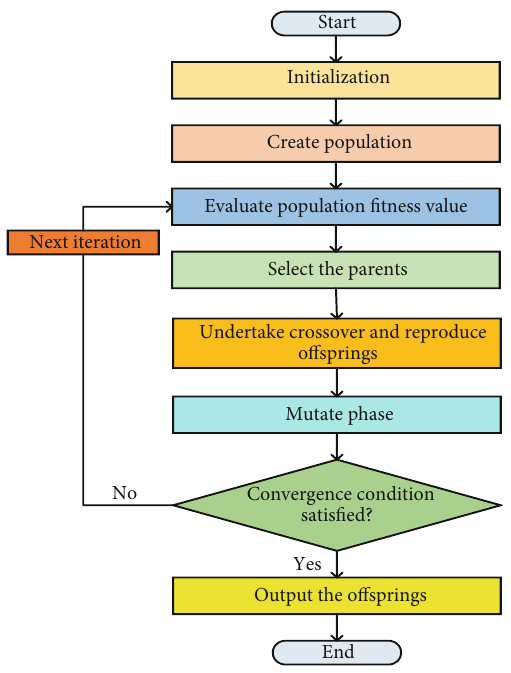
Figure 12: Flowchart for the GA